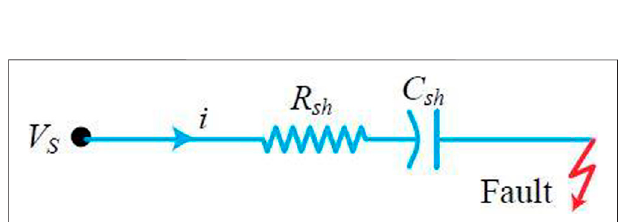
FIGURE 7 | Off-state equivalent CBFCL in the PMSG wind